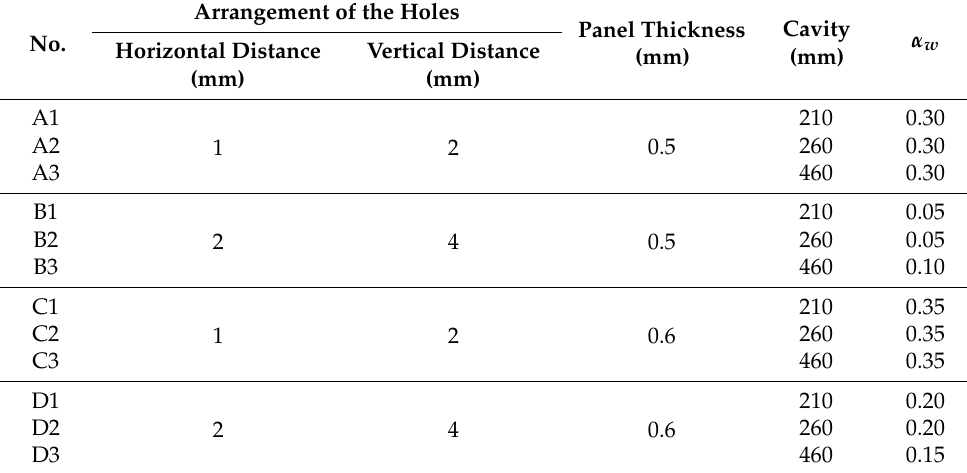
Table 1. The specimen setting and measurement results of expanded metal mesh (EMM).